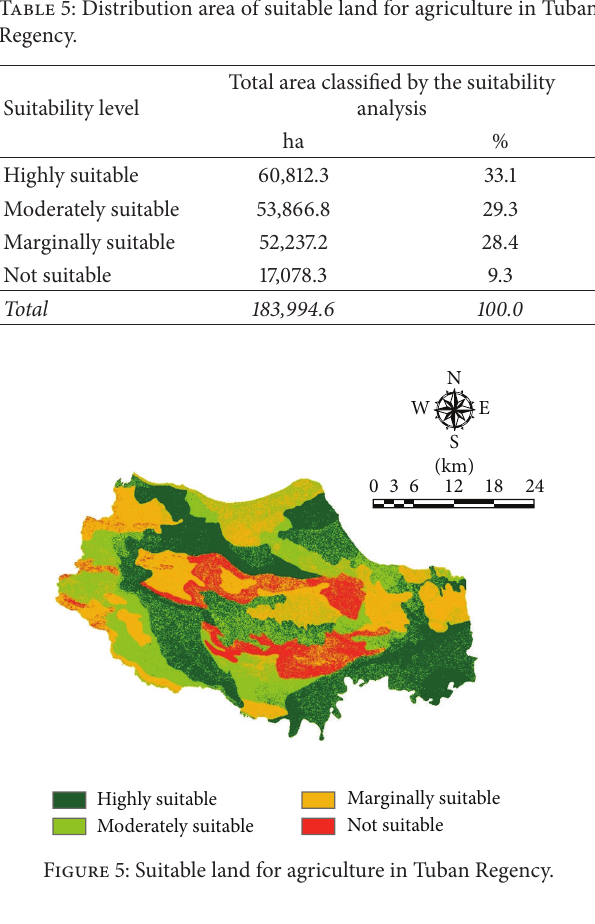
tourism, housing, industry and warehouse, plantation, fish landing centres, ports, mines, swamps, ponds, and